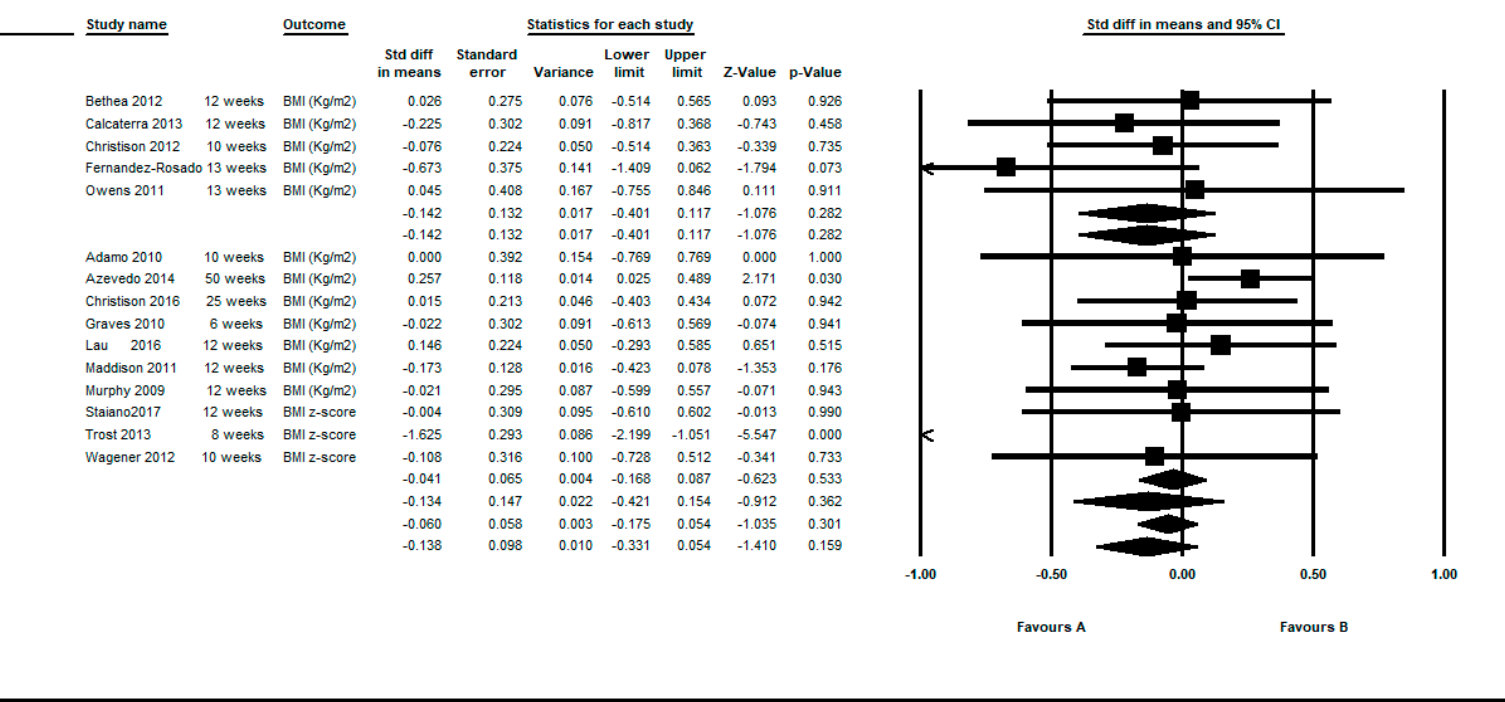
Figure 4. Pre-post intra-group difference in BMI in the group intervened with active video games. All measurements in the shortest follow-up.